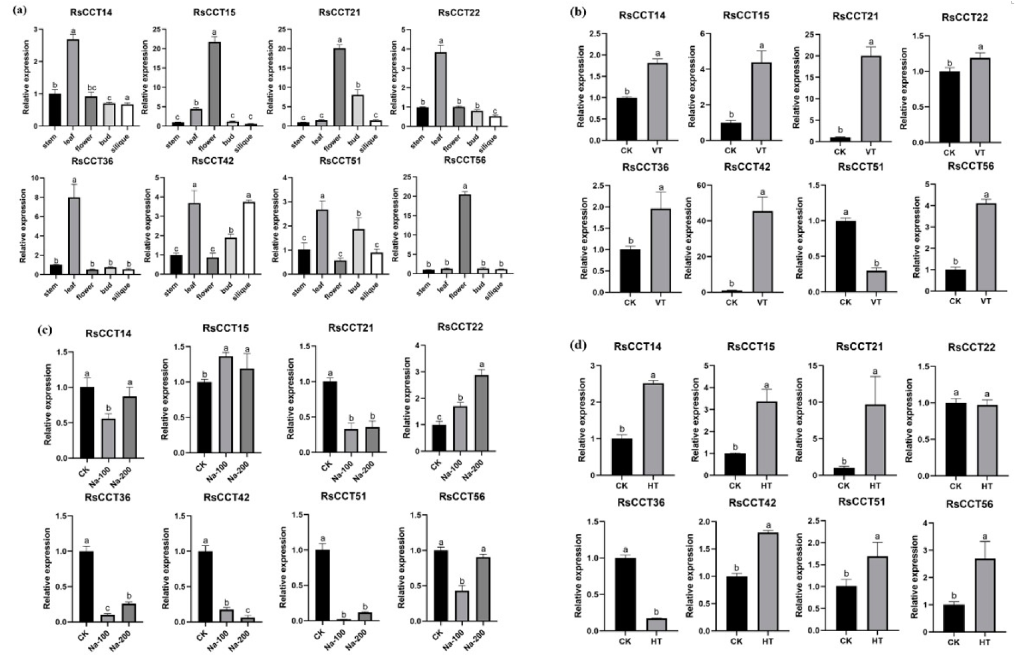
Figure 7. The expression levels of representative RsCCT genes ( a ) of five radish tissues (stem, leaf, flower, bud, and siliques) under ( b ) vernalization treatment, ( c ) salt stress, ( d ) heat stress. Each error bar indicates standard deviation among three biological replicates. The value with different letter indicates significant difference at p <